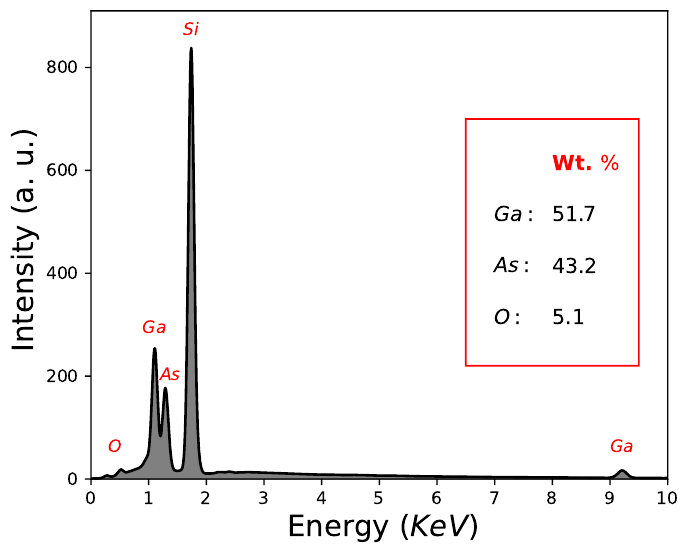
Figure 3. Quantification results by EDS corresponding to sample M2. The existence of crystallographic planes of Ga 2 O 3 confirms the existence of oxygen in samples. We think that oxygen atoms enter the GaAs lattice to replace arsenic, even knowing that the difference in atomic radius is not the same; As (115 pm) and oxygen (73 pm) there are no significant changes in the crystal structure since the lattice parameters are very close to those reported for bulk GaAs. Figure 4 shows Raman spectra of samples M1 (800 ◦ C), M2 (900 ◦ C) and M3 (1000 ◦ C). Two characteristic shoulders close to 261 cm − 1 and 285 cm − 1 attributed to TO and LO modes of GaAs are observed. Such modes related to Ga x As y are responsible for the appearance of the growth direction plane (111) in XRD patterns; this effect was also observed by Bernal et al. [28]. Furthermore, a band at 576 cm − 1 corresponding to the 2LO mode of GaAs appears for sample M1. On the other hand, no signals o modes were observed regarding the Silicon substrate. Due to the average thickness of the GaAs samples ( ∼ 643 nm), the Raman penetration depth is insufficient to generate interaction with the Silicon substrate.